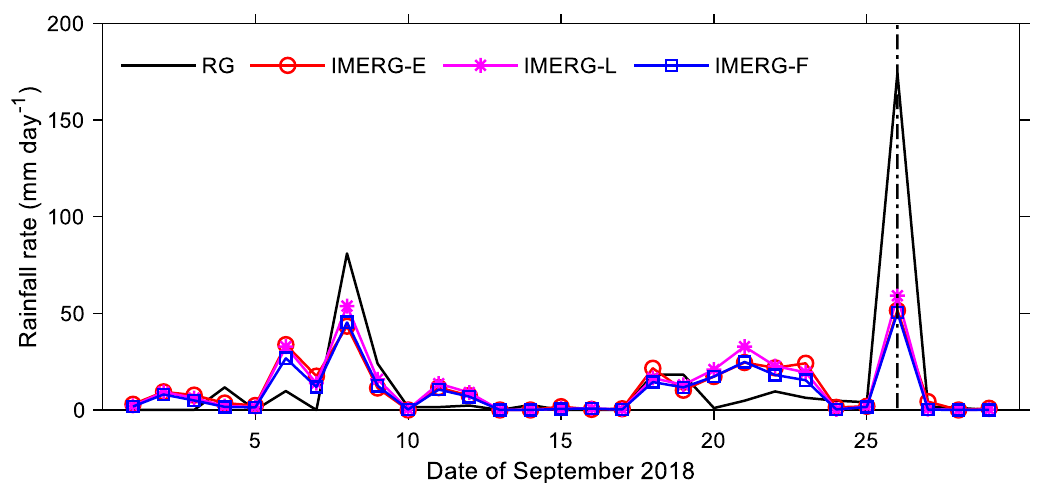
Figure 2. Time series of daily rainfall from RG at Padang, West Sumatra (0.996° S, 100.372° E), along with IMERG-E, IMERG-L, and IMERG-F data during 1–29 September 2018. The vertical dotted line indicates the flood of September 26, 2018.